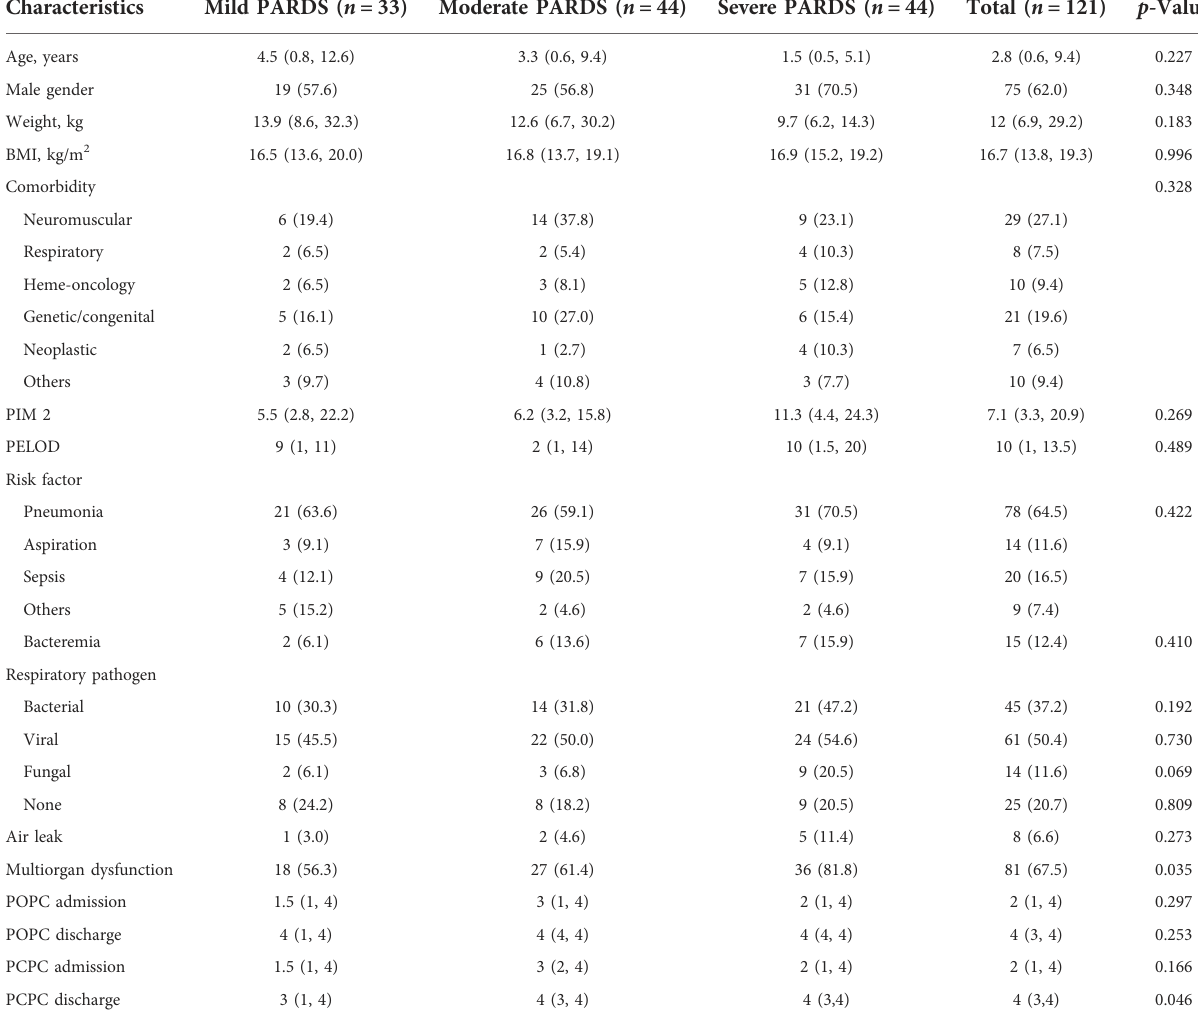
TABLE 1 Characteristics of patients with pediatric acute respiratory distress syndrome.